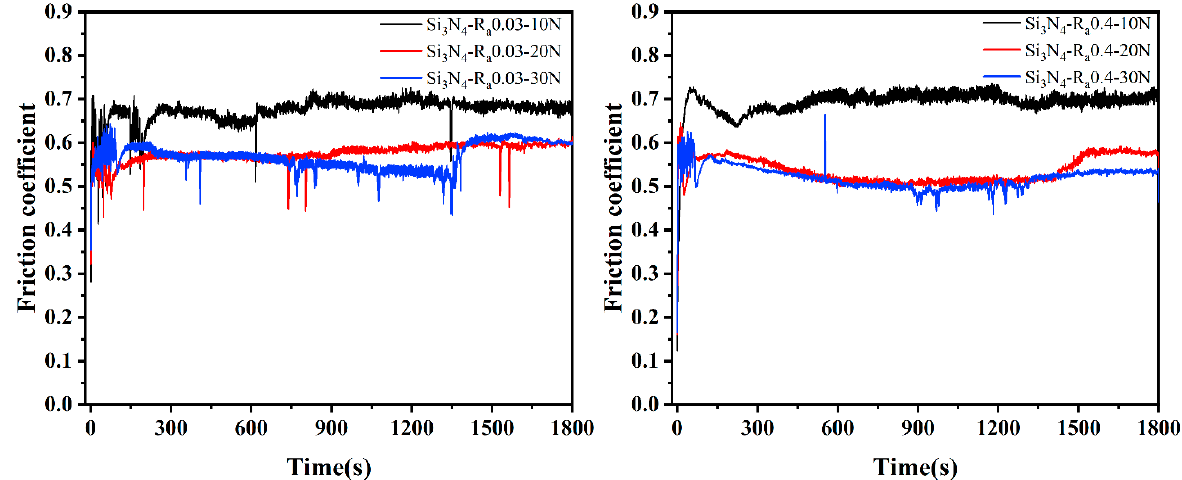
Figure 8. Friction coefficient of Si 3 N 4 substrate with different roughnesses.